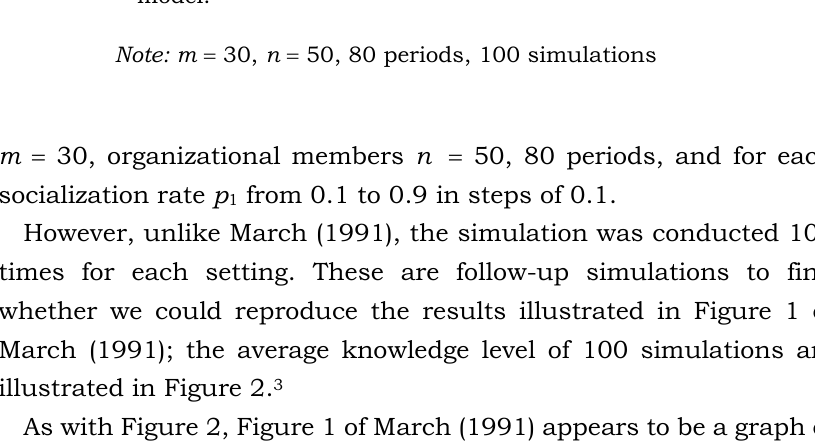
Figure 2. Average knowledge levels of March’s (1991)